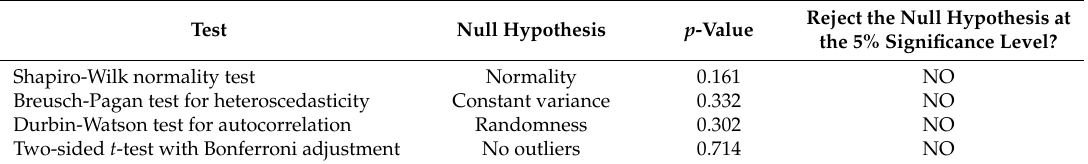
Figure 6. 2D density plot (log-scale) for the model’s independent variables. Table 5. Summary of residuals Table 4. Model summary and ANOVA.